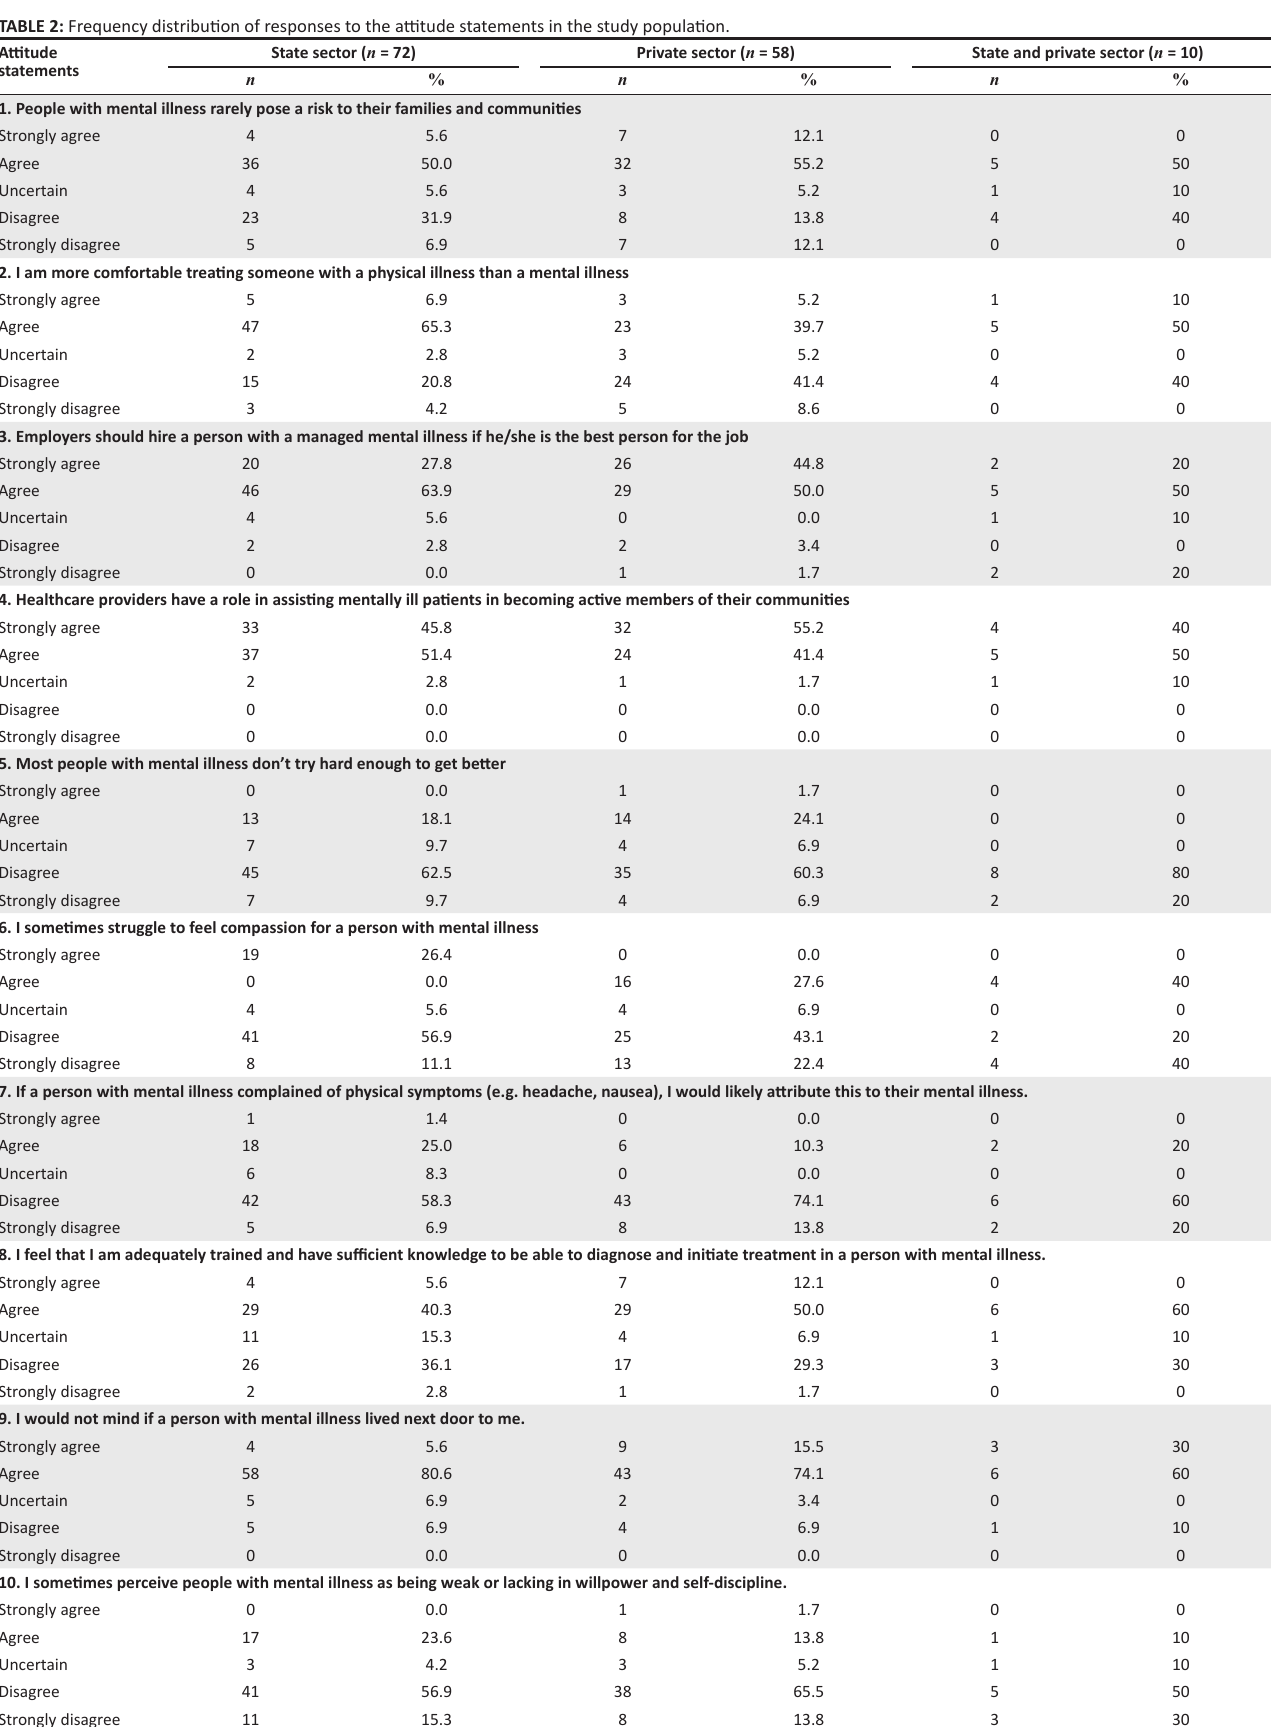
TABLE 2: Frequency distribution of responses to the attitude statements in the study